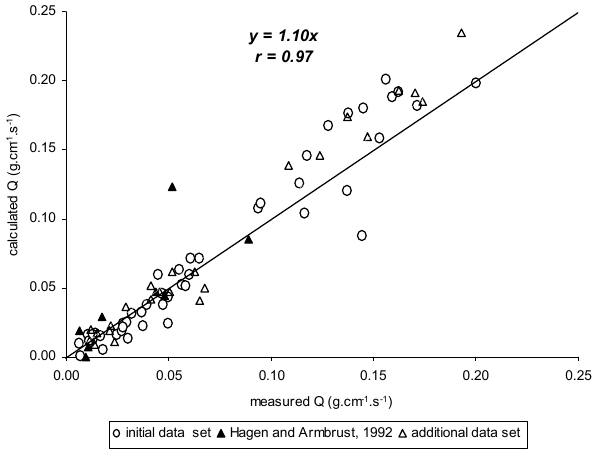
Fig. 8. Comparison between calculated and measured erosion fluxes including the data from Hagen and Armbrust (1992) (n=80).